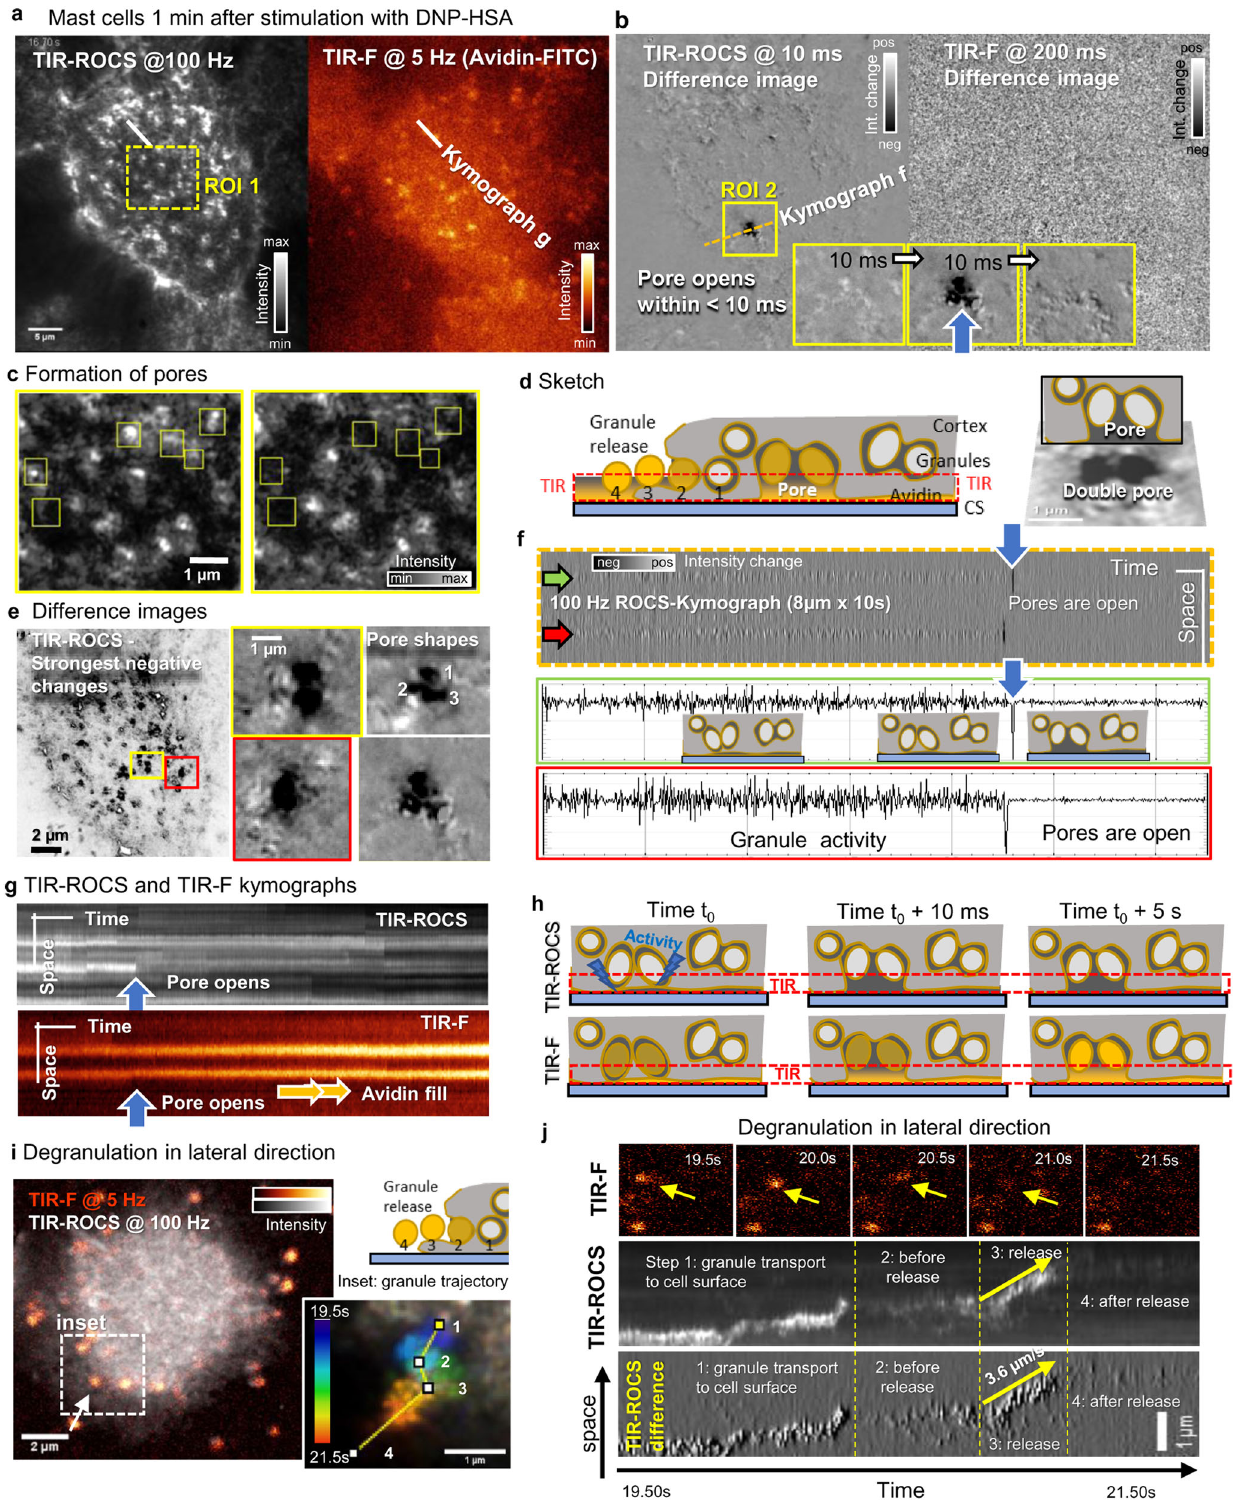
marked above indicates a radial linescan 1 and a lateral linescan 2 for two kymographs. A nearly exponential decay of the TIR-ROCS signal along a single fi lopodium reveals a high actin backbone retraction speed of v = 5 μm/s. The second kymograph shows the overall signal reduction of 10 adjacent fi lopodia (previous fi lopodium marked in red), likely from backbone retractions. A linescan (dark blue) through the whole section of the cell, which